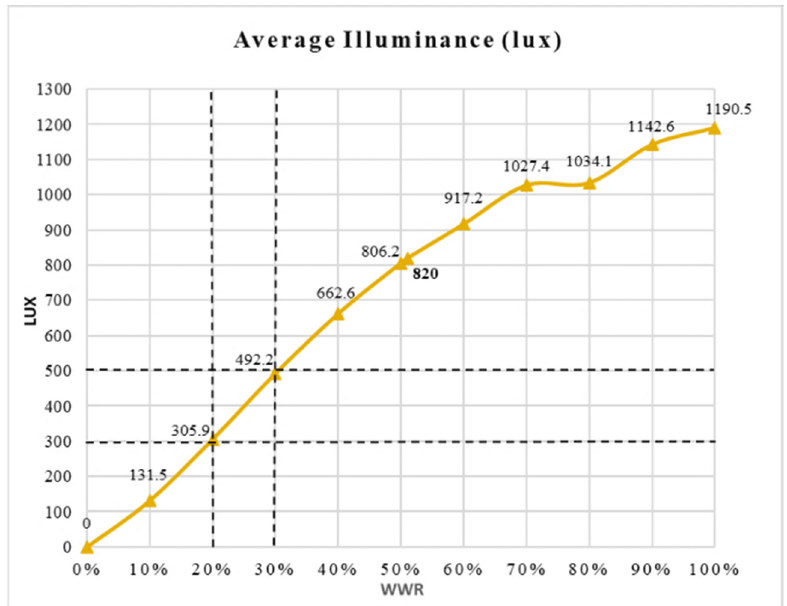
Figure 6. Effect of west façade WWR on building energy use per total floor area (baseline simulation values highlighted in bold).